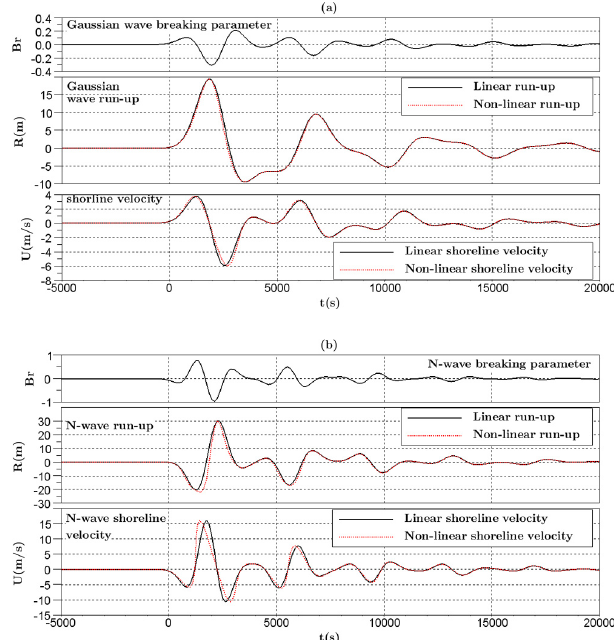
Fig. 6. Breaking parameter Br, linear (solid line) and nonlinear (dash line) variations of water level R on shore and shoreline veloci- ties U versus time for h0=4000m, h1=200m, tan α = 0 . 005, x 0 = 40km, tan α = 0 . 1, x 2 = 23km, and M = 8: (a) Gaussian wave, and (b) N